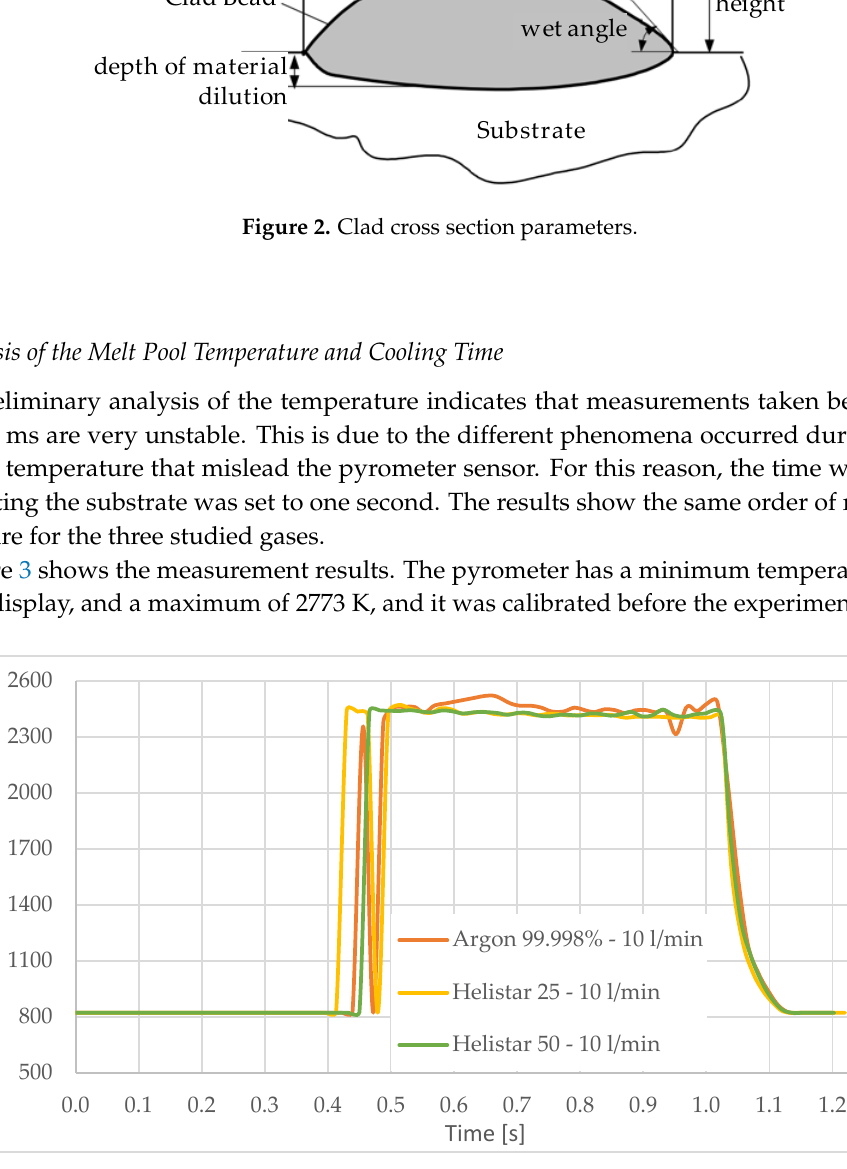
Figure 3. Temperature [K] vs. time [s].